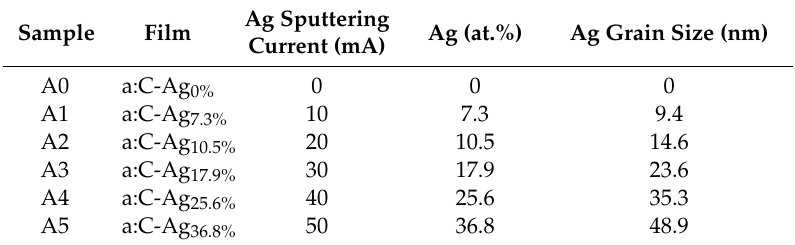
Table 1. Ag sputtering current and atomic percentage of six a:C-Ag x film